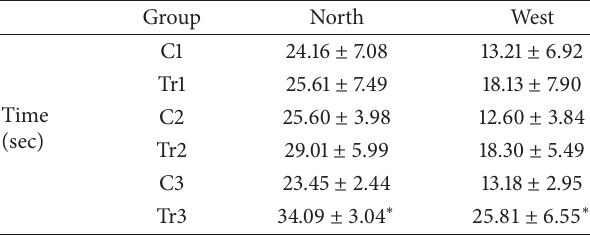
Table 4: Average latency to reach the visible platform (southwest quadrant)forcontrol(C1,C2,andC3)andtreated(Tr1,Tr2,andTr3) groups after north or west introduction. Data are shown as mean values ± SEM. ∗ 𝑃 < 0.05 versus corresponding control. Group North